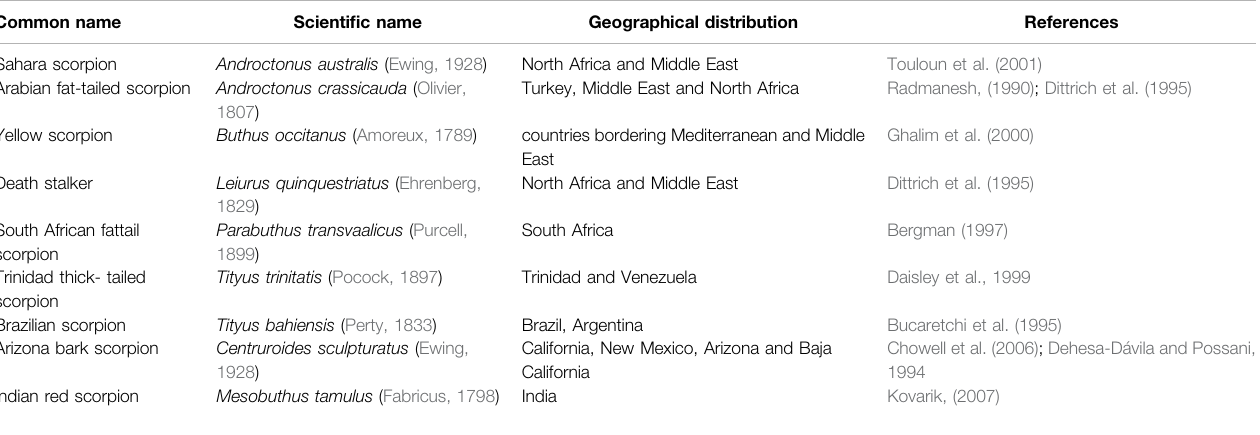
TABLE 1 | List of some of the most dangerous and deadly scorpion species distributed across the